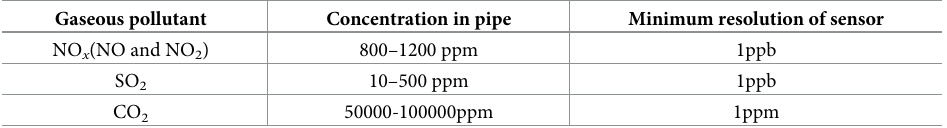
Table 1. Emission distribution and sensor resolution of different gaseous